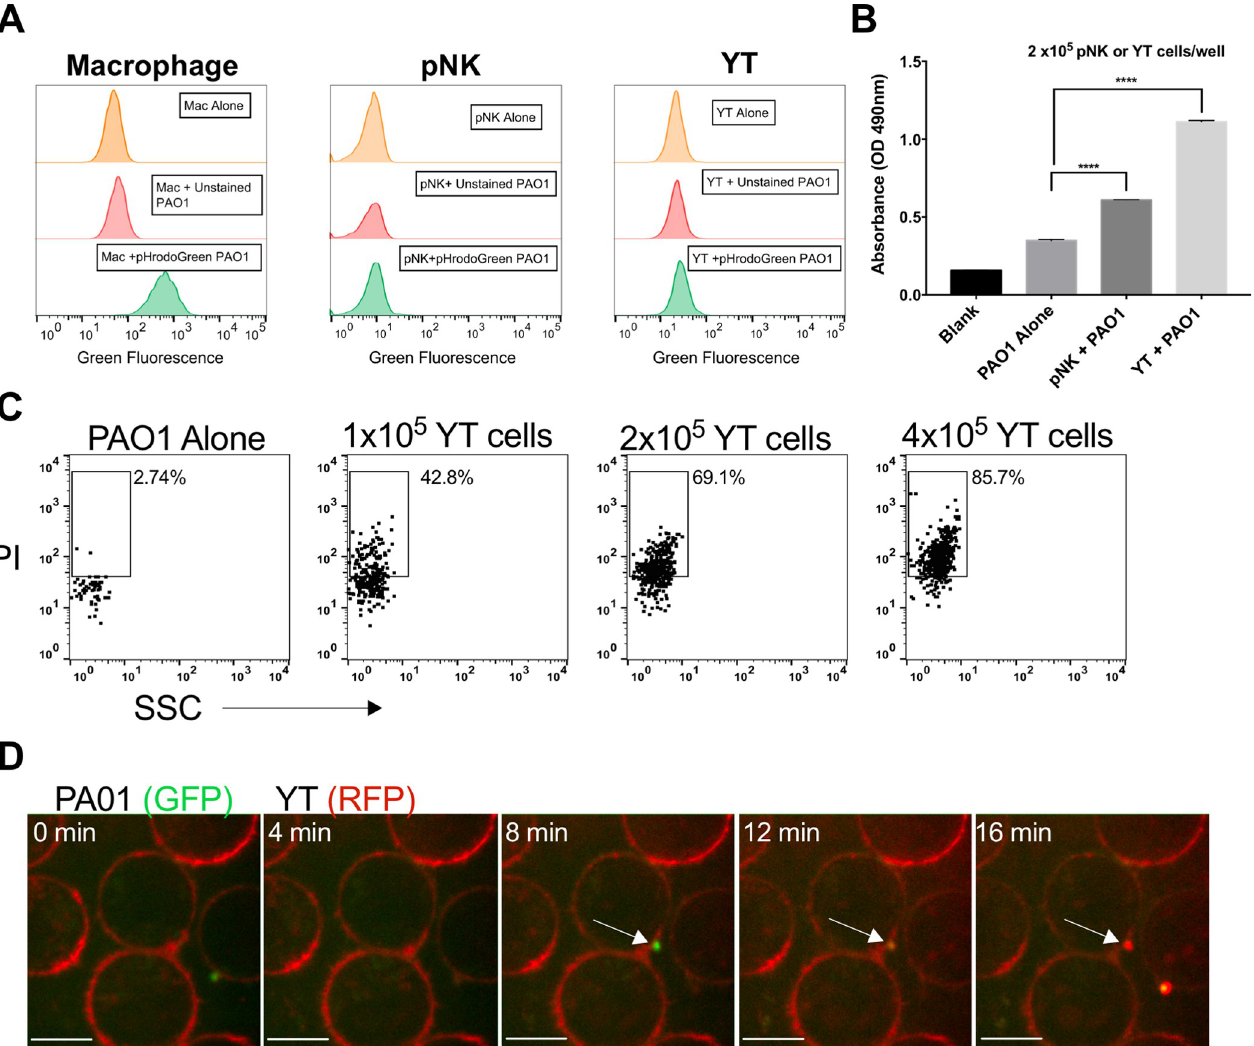
Fig 2. pNK and YT cells do not phagocytose P . aeruginosa PAO1, but they do directly induce membrane damage. (A) Human macrophage, pNK or YT cells co-cultured with or without PAO1 at a 200:1 MOI for 1 hr. PAO1 was either unstained or stained with pHrodo Green AM dye to measure phagocytosis in the different cell types. A shift in green fluorescence as measured by the flow cytometer indicates phagocytosis of PAO1 by the cell type. Graph is representative of N = 2 biological replicates carried out on different days. Gating strategy in S4 Fig. (B) PAO1 incubated alone or in the presence of YT or human primary NK cells for 6 h followed by addition of 1mM nitrocefin for 12 h. (C) Representative flow cytometry plot of Propidium iodide (PI) staining of PAO1 that were either cultured alone or with YT cells for 2 h in culture media containing PI. (D) YT cells, expressing RFP actin, co-cultured with GFP PAO1. Membrane permeability was determined by the addition of PI to the media. Images were acquired every 15 seconds and representative images are shown at 2-minute intervals. Scale bar = 10 μ m. The video (Supplementary Video 1) is representative of at least 3 separate experiments. In all co-culture experiments, conditions were carried out in n = 4 wells (mean ± SEM) and the graph is representative of n � 3 biological replicates performed on different days. � = P � 0.05, �� = P � 0.01, ��� = P � 0.001. NS not significant. membrane (OM) of PAO1 was damaged following co-culture with pNK and YT cells, we used a colorimetric assay based on the processing of the cephalosporin, nitrocefin, by beta lacta- mases within the periplasm of Gram-negative bacteria (Fig 2B). The OM is normally imperme- able to nitrocefin, but when it is damaged, nitrocefin gains access to the periplasm where it is converted from yellow to red, with color change to red indicating outer membrane permeabil- ity [37,38]. The absorbance readings showed that there was a significant increase in the